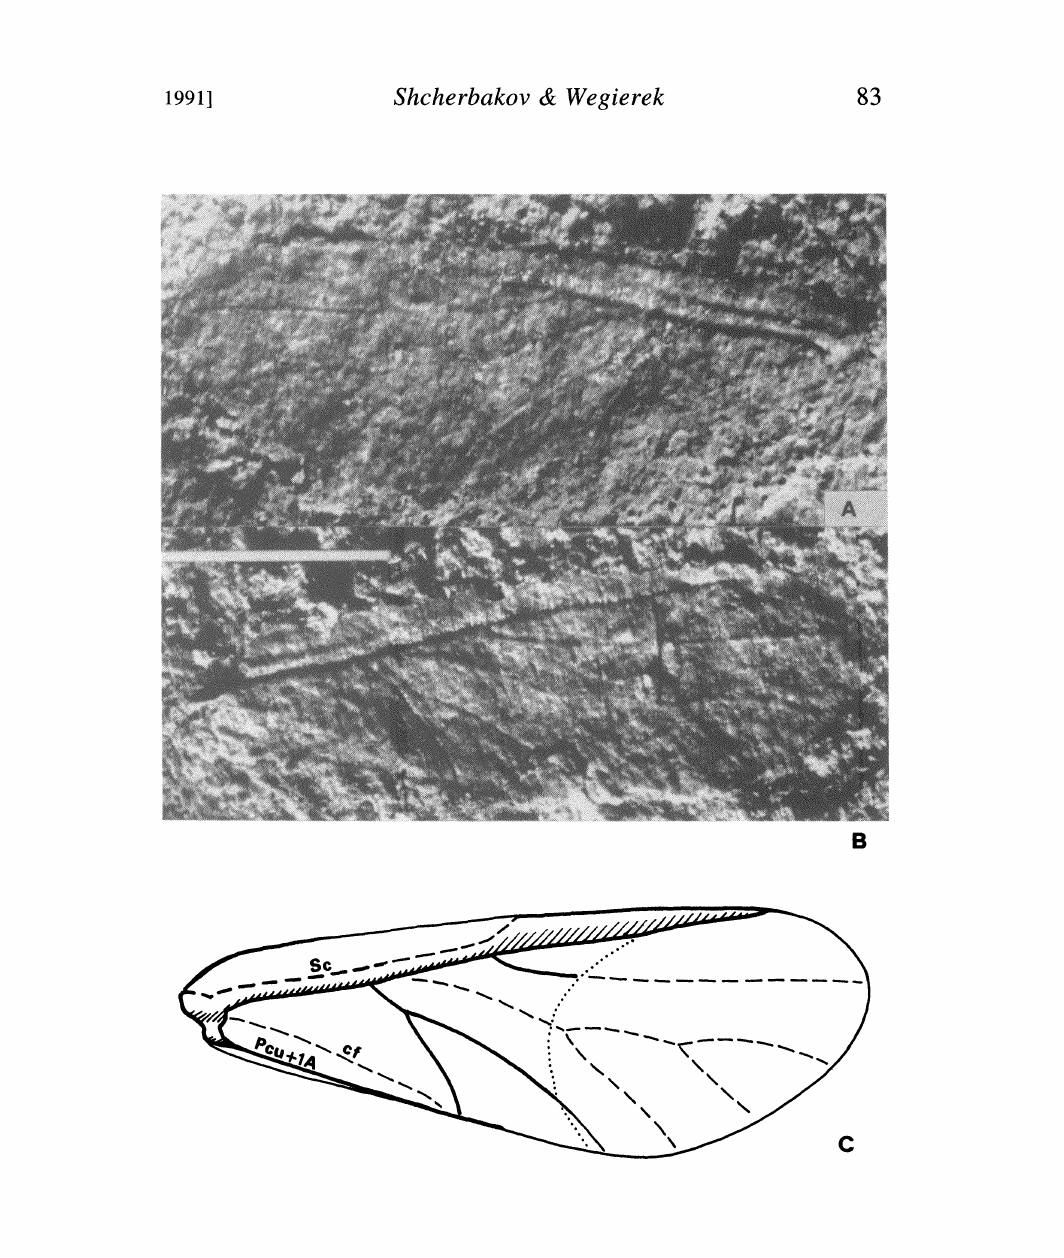
Fig. 1. Creaphis theodora, holotype; forewing, PIN 2240/3240: A, part; B, counterpart. C, venation. Scale bar lmm. Convex veins in continuous line, con- cave veins in broken line, nodal line in dotted line; cf, claval